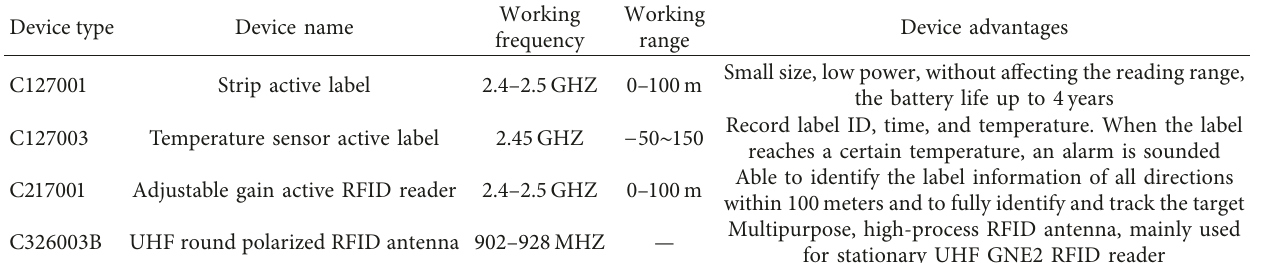
Table 2: RFID device pick list.